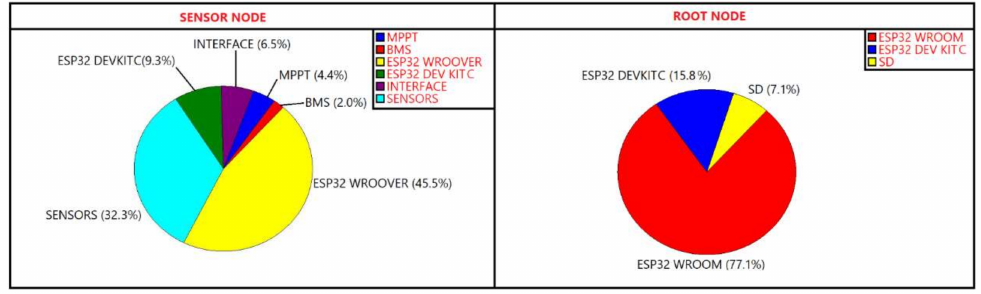
Figure 4. Pie charts of the subsystems that make up sensor node on the left side and root node on the right side highlighting all the subsystems that compose the